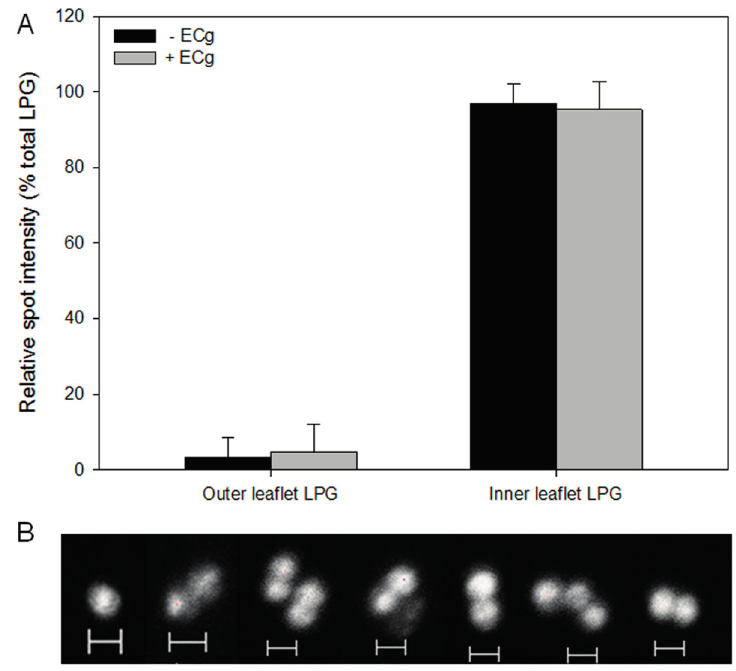
Figure 5. The degree of LPG asymmetry of the EMRSA-16 CM is unaffected by intercalation of ECg into the bilayer. ( A ) Relative LPG content of the outer and inner leaflets of the CM in the presence or absence of 12.5 µg/mL ECg ( n = 5). No significant difference between control and ECg-grown bacteria was found: p > 0.1; two-tailed Student’s t . Outer leaflet LPG was quantified by measurement of membrane-bound fluorescamine, which does not cross the bilayer; inner leaflet LPG was quantified with ninhydrin after lipid separation on 2D-HPTLC plates; ( B ) CLSM of EMRSA-16 labelled with fluorescamine. Scale bars 1